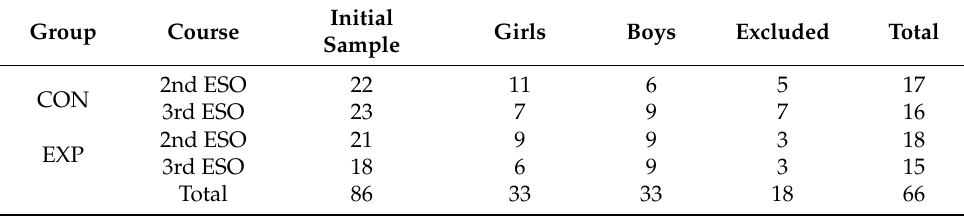
Table 1. Initial and final sample according to the sample selection requirements. Initial Group Course Girls Sample 2nd ESO CON EXP